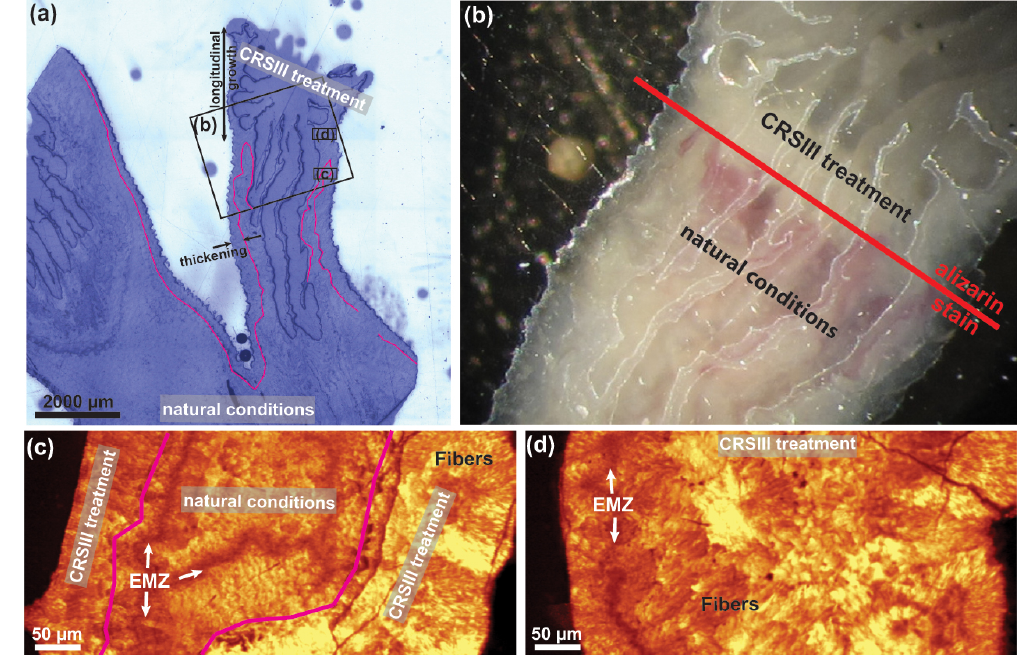
Figure 2. (a) Lophelia pertusa cut in longitudinal plane through an old and younger colony branch. Pink line outlines the position of the staining lines and separates the skeleton grown under natural and high CO 2 treatment conditions (CRSIII p CO 2 = 982). (b) Close-up of side branch and location of the staining edge above all skeleton was formed during treatment conditions. (c, d) Raman map of the intensity distribution of the main aragonite peak (symmetric stretch, 1085cm − 1 ) reveals the early mineralization zone (EMZ), the primary skeleton and the area of secondary thickening precipitated for both natural and treatment